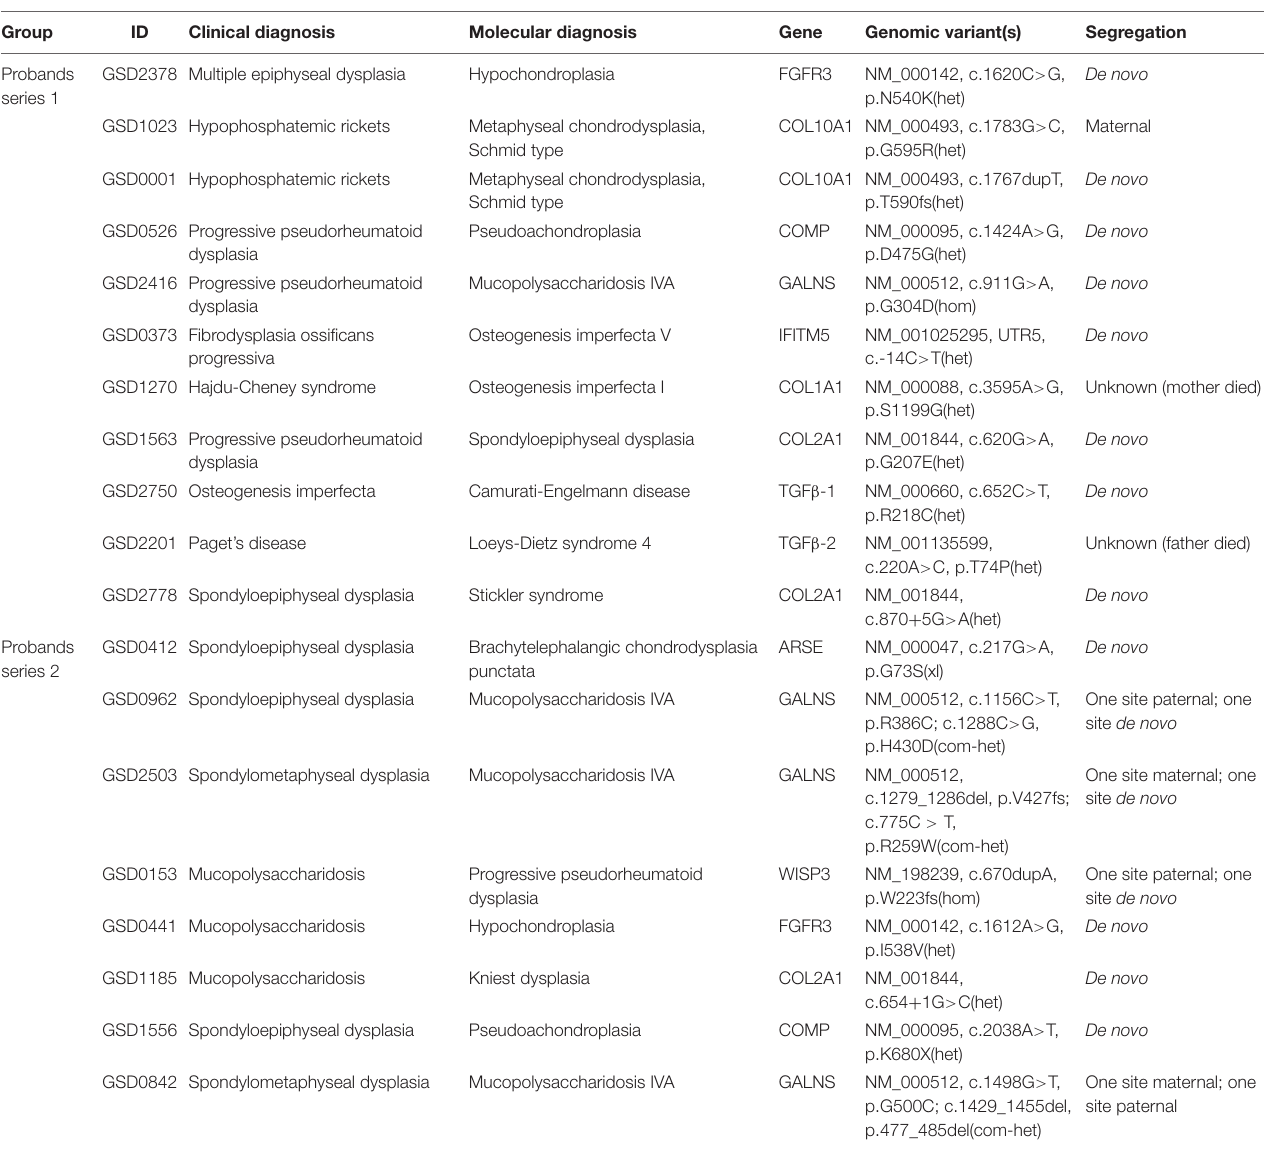
TABLE 3 | Pathogenic variants in the 19 probands with modified molecular diagnoses.